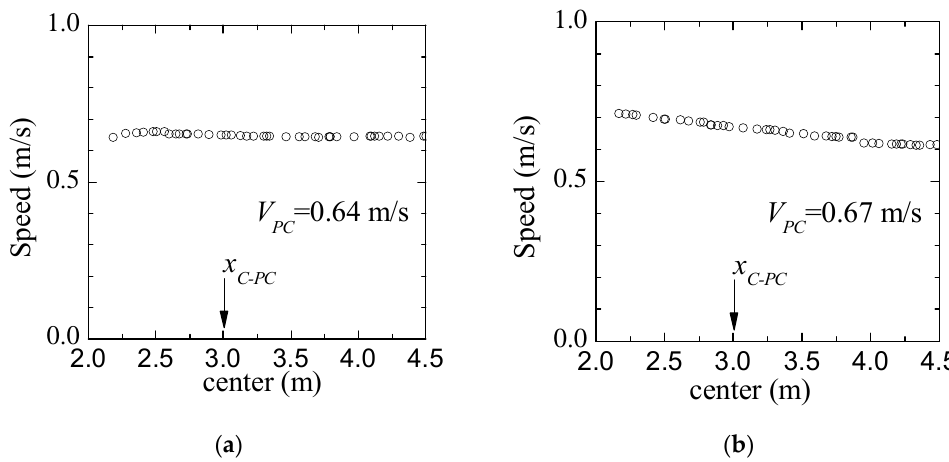
Figure 8. Speed estimation of two test subjects (( a ) and ( b )) along the same walking path obtained using the proposed approach (empty circles). The speed estimated using the photocell barrier is also reported in the graphs. Note that the coordinate x C-PC marks the location of the center of the 4 m segment, along the walking path, at the ends of which the photocell barriers are located. Therefore, we expect the walking speed at x C-PC to coincide with the average speed V PC estimated by means of photocells. Note that in Figure 8athe test subject appears to be moving at a constant speed, while in the case of Figure 8b the fact that the test subject is slowing down while proceeding is clearly detected.